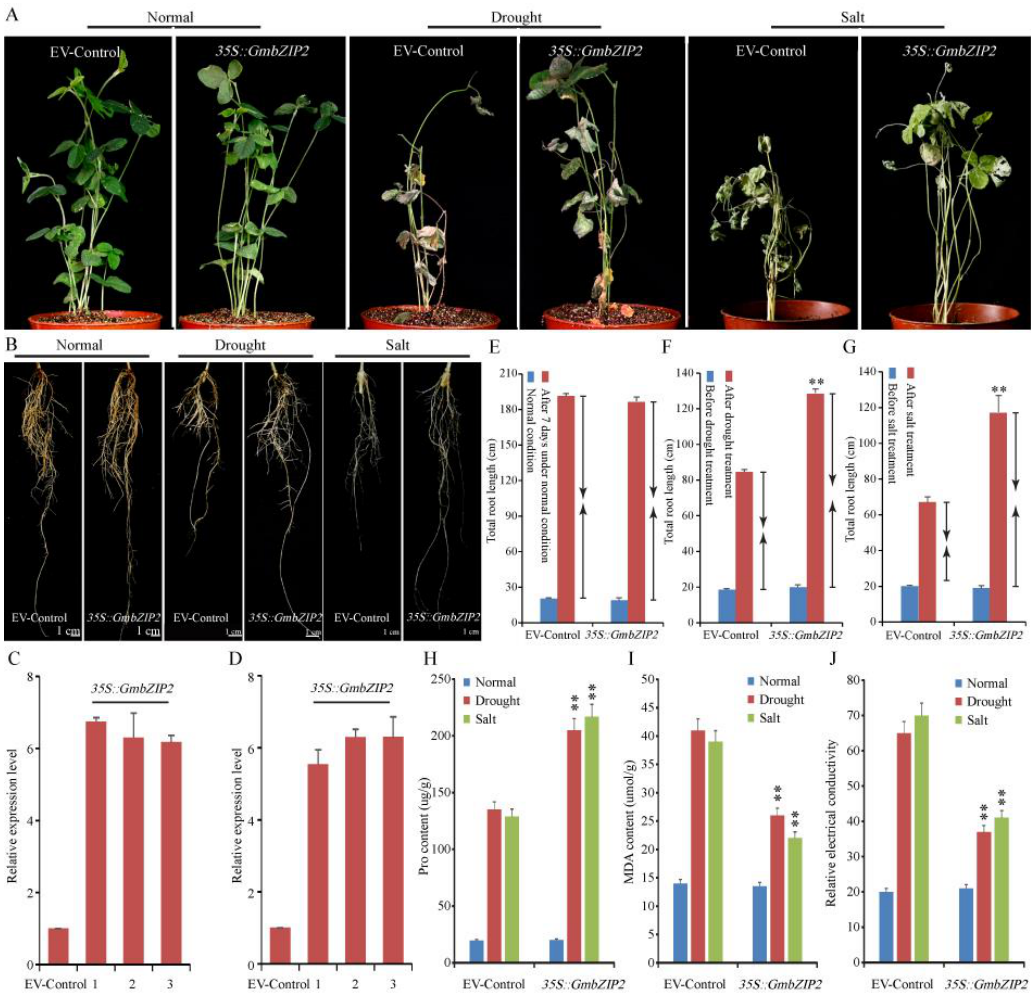
Figure 9. Phenotype and function identification of soybean GmbZIP2 under drought and salt stresses. ( A , B ) Growth states of transgenic soybean hairy root composite plants and EV-control (the empty plasmid of pCAMBIA3301) plants under drought and salt stresses. ( C , D ) Transcriptional level of GmbZIP2 in transgenic soybean hairy roots. ( E ) The root elongation of transgenic soybean hairy root composite plants and EV-control plants under non-stress condition. ( F ) Root elongation of transgenic soybean hairy root composite plants and EV-control plants under drought condition. ( G ) Root elongation of transgenic soybean hairy root composite plants and EV-control plants under salt condition. ( H ) Proline content of transgenic soybean hairy root composite plants and EV-control plants under drought and salt conditions. ( I ) MDA content of transgenic soybean hairy root composite plants and EV-control plants under drought and salt conditions. ( J ) Relative electrical conductivity of transgenic soybean hairy root composite plants and EV-control plants under drought and salt conditions. Vertical bars indicate ± SE of three replicates. ** indicates significant differences in comparison with the control lines at p < 0.01.